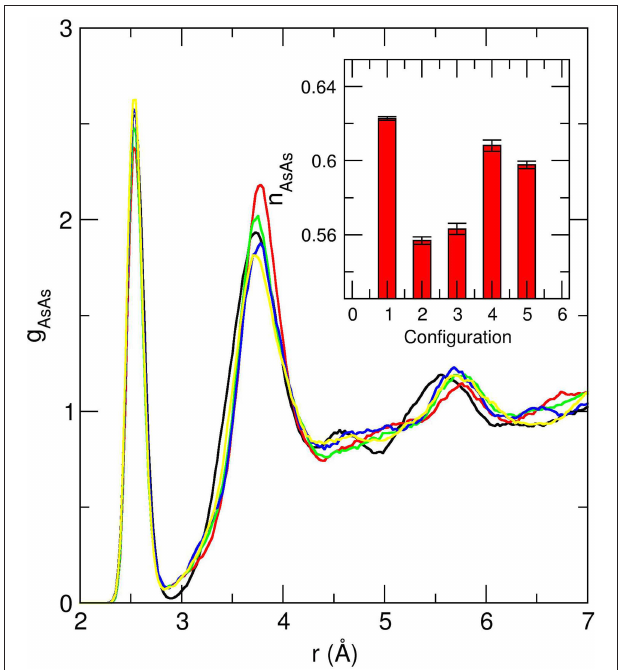
FIGURE 2 | Calculated As-As partial pair correlation function g AsAs for five independent quenched configurations of amorphous As 2 Se 3 . The inset shows the corresponding obtained AsAs coordination number n AsAs for the five configurations.